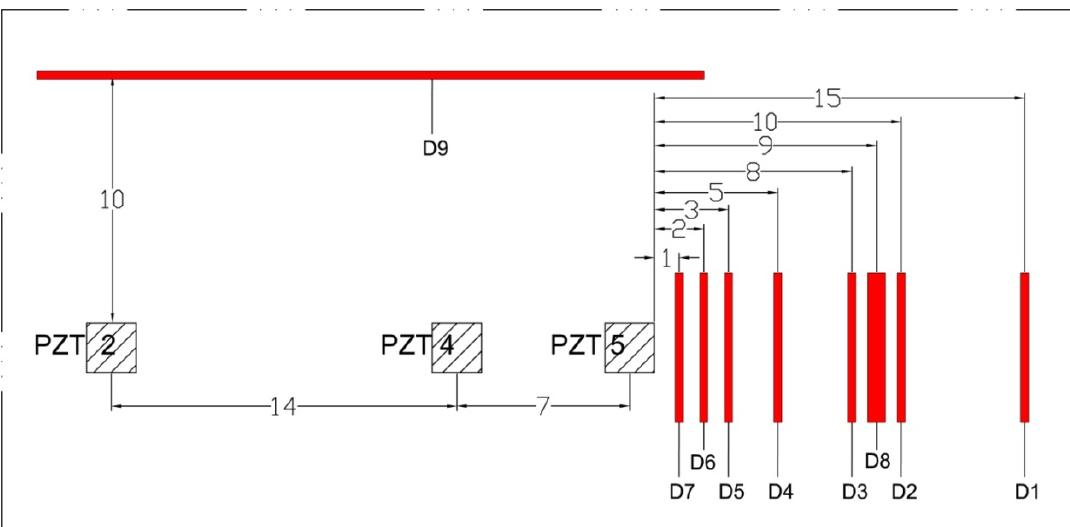
Figure 9. Location and sequence of damages for EMI method.